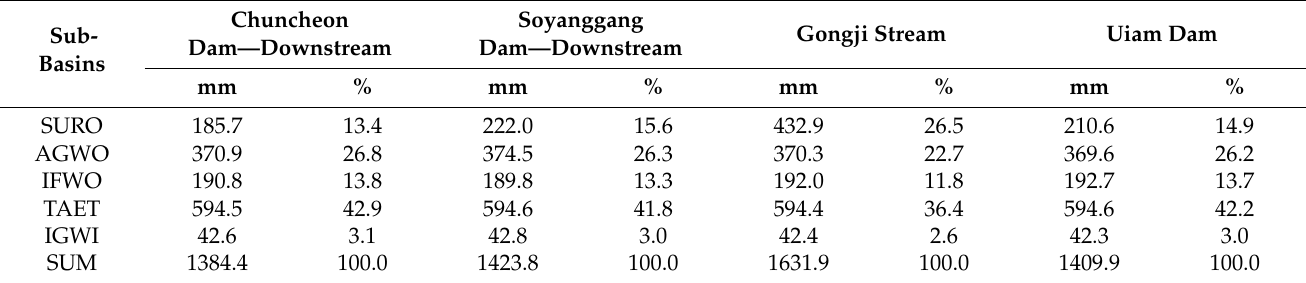
Table 5. Hydrologic components for each sub-watershed from Scenario